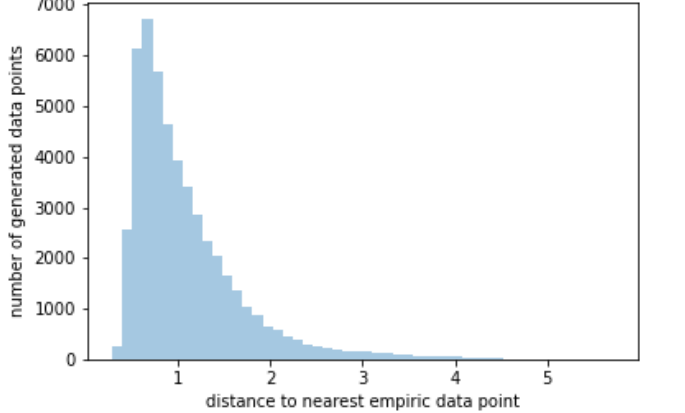
Figure 5. Histogram of minimum distances of the generated data points to the empirical data